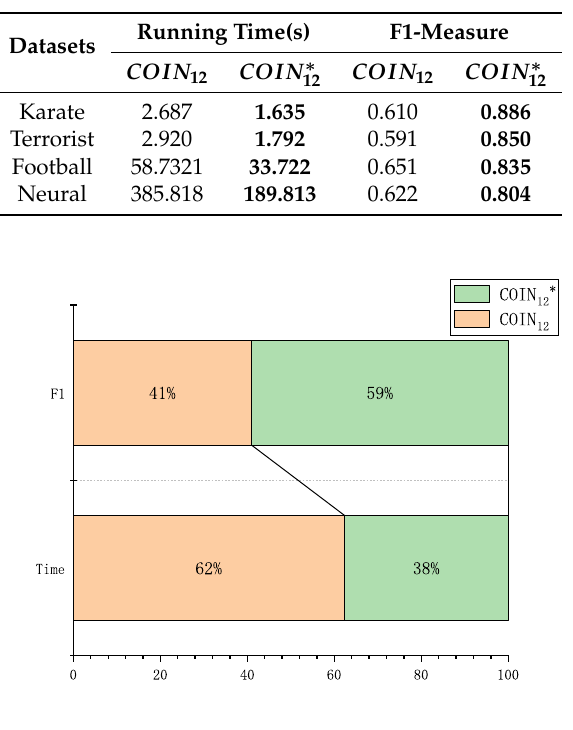
Figure 5. The running time ratio and F1 ratio on Terrorist between COIN 12 and COIN ∗